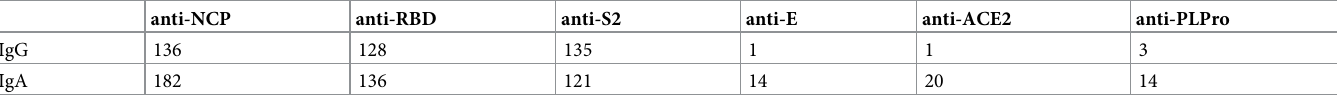
NCP- nucleocapsid protein, RBD-receptor binding domain within Spike protein, S2- domain S2 within Spike protein, E- envelope protein, ACE2- angiotensin- converting enzyme 2, PLPro- papain-like